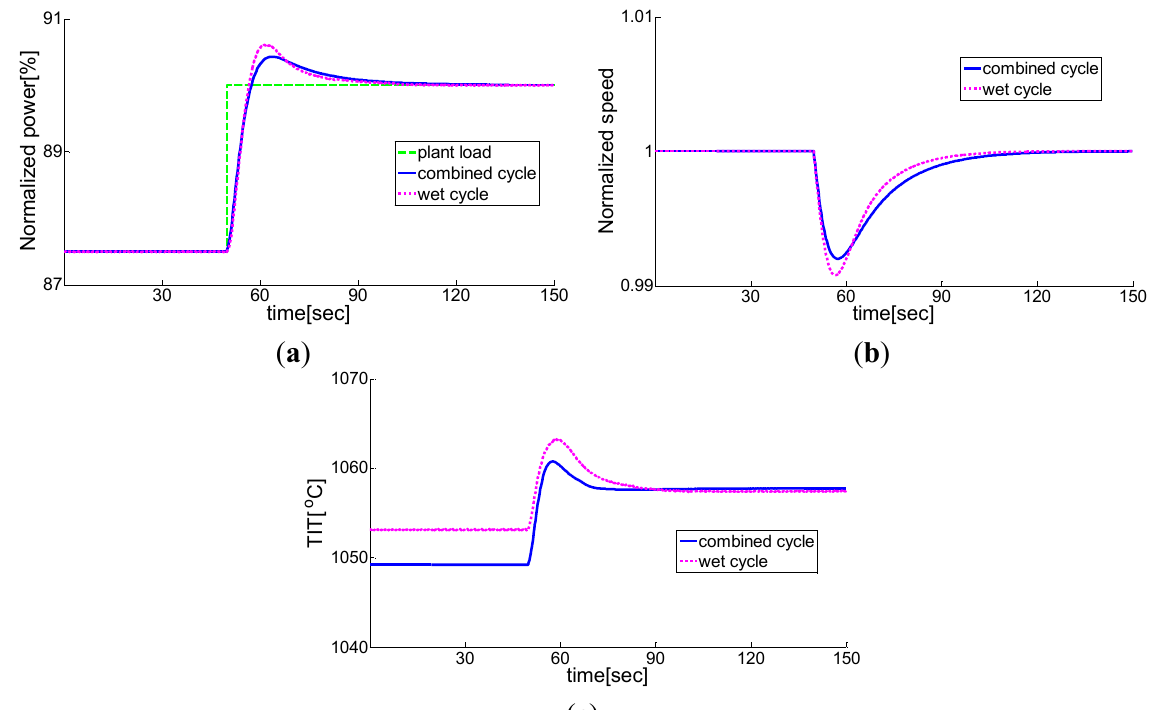
Figure 4. Performance of the combined cycle vs. STIG cycle—2.5% step change load (plant loading from 87.5% to 90% of plant load); ( a ) Normalized power, ( b ) Normalized speed, ( c ) Turbine inlet temperature (TIT).